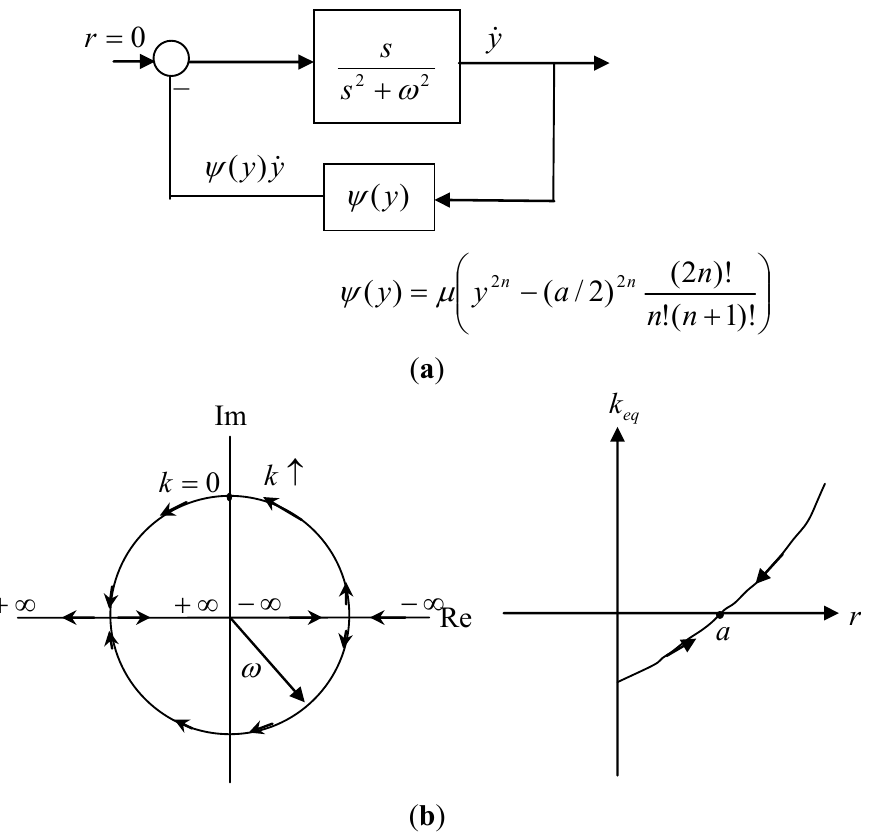
Figure 1. Synthesis of HD-VDP oscillators. ( a ) Feedback representation of van der Pol oscillators; ( b ) Root Locus and Equivalent